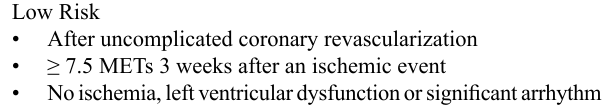
Chart 5. Criteria defined by Pashkow for risk stratification of events during the